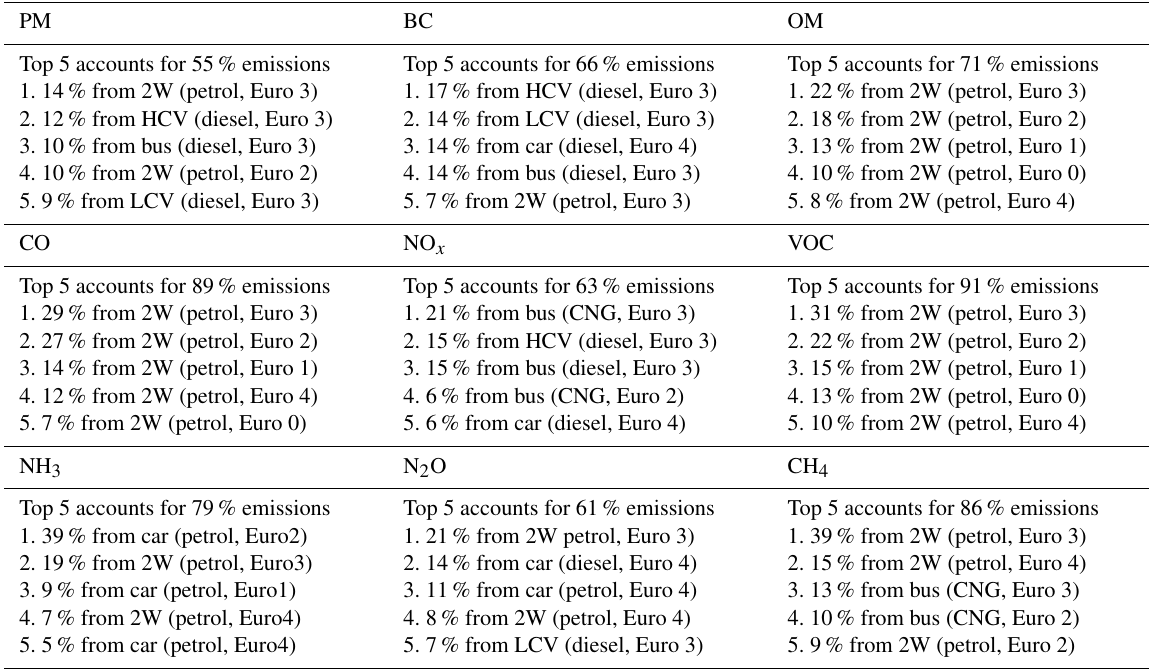
Table 5. Top five polluting vehicle categories for each pollutant. PM BC OM Top 5 accounts for 66% Top 5 accounts for 55% emissions 1. 14% from 2W (petrol, Euro 3)